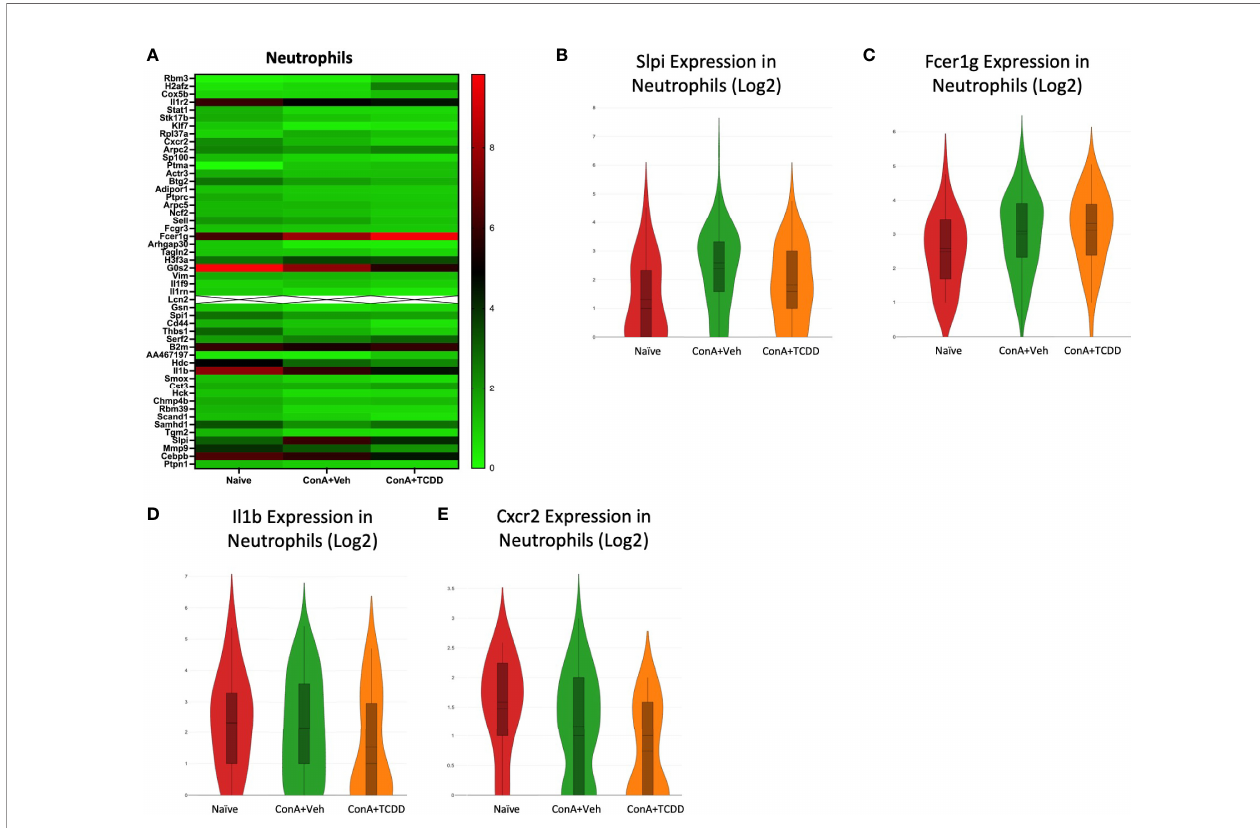
FIGURE 7 | Analysis of gene dysregulation in Neutrophils. C57/BL6 mice were injected with ConA followed by vehicle or TCDD 1 hour later as described in Figure 1 legend. Liver in fi ltrating cells were isolated and scRNA-seq was performed as described in Methods. Heatmaps consisting of the top 50 differential genes per treatment were generated using Loupe Browser. Heatmaps of differentially expressed genes from (A) Neutrophils. In panel (A) , the X marked with some genes represents an expression level over 20. (B – E) Violin plot of Log2 expression of target